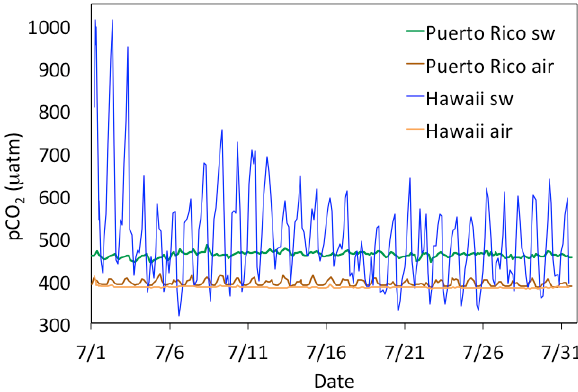
Fig. 1. Air and surface seawater p CO 2 (µatm) from two near-shore environments in Hawaii and Puerto Rico during summer of 2008 and 2009, respectively, showing p CO 2 levels that on average are significantly higher than expected from equilibrium with the atmo- sphere. On occasion p CO 2 levels at the Hawaii site have been ob- served to exceed 1000µatm, which is much higher than the lev- els predicted to occur in the atmosphere in the year 2100 under a business-as-usual CO 2 emission scenario. Data courtesy: Eric De- Carlo, University of Hawaii, Dwight Gledhill, NOAA AOML, and Chris Sabine, NOAA PMEL. http://www.pmel.noaa.gov/co2/story/